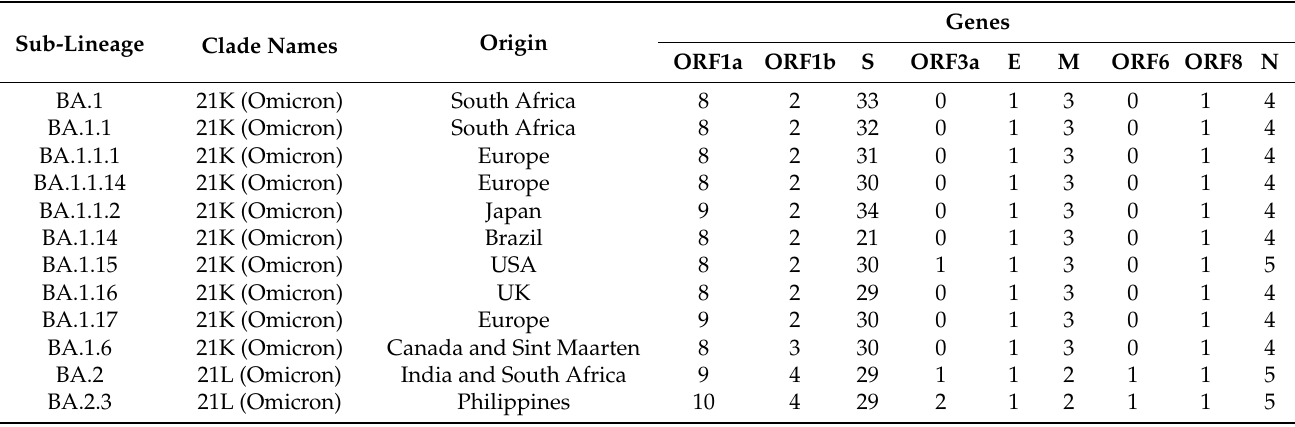
Table 1. List of Omicron sub-lineages circulating in Ecuador. For each Omicron sub-lineage, the place/s of origin and mutation numbers that characterize them are recorded.